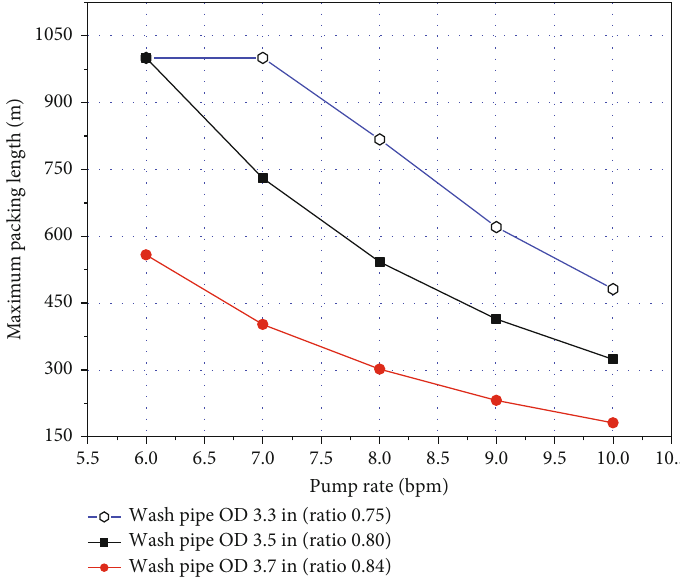
Figure 7: Change of packing length with pump rate under washpipe/screen (screen ID: